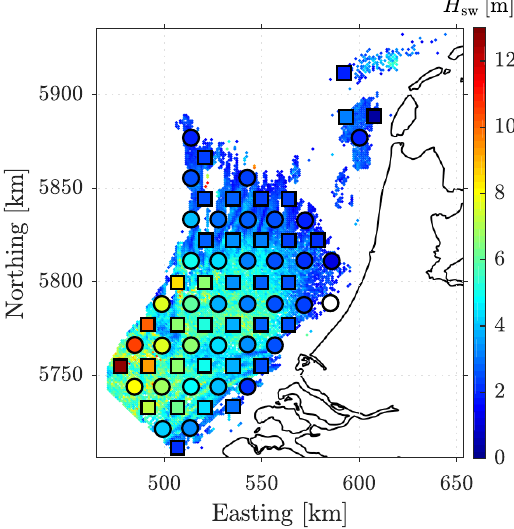
Figure 10. Modeled sand wave heights after rescaling H res sw , using the obtained correlation curve based on calibration locations only (the blue line in Figure 9). The background shows observed sand wave heights H obs sw [12,33]. White markers indicate locations for which the model predicts no sand waves to